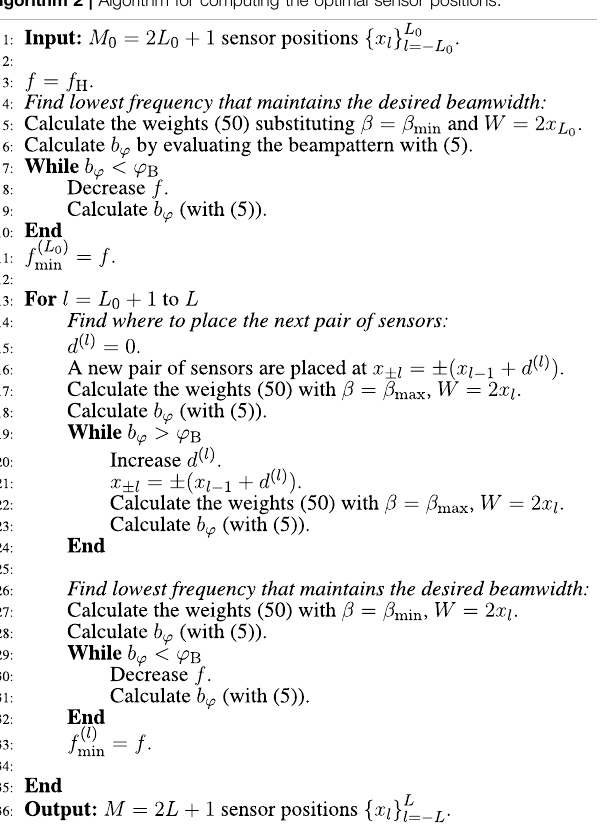
Algorithm 2 | Algorithm for computing the optimal sensor positions.